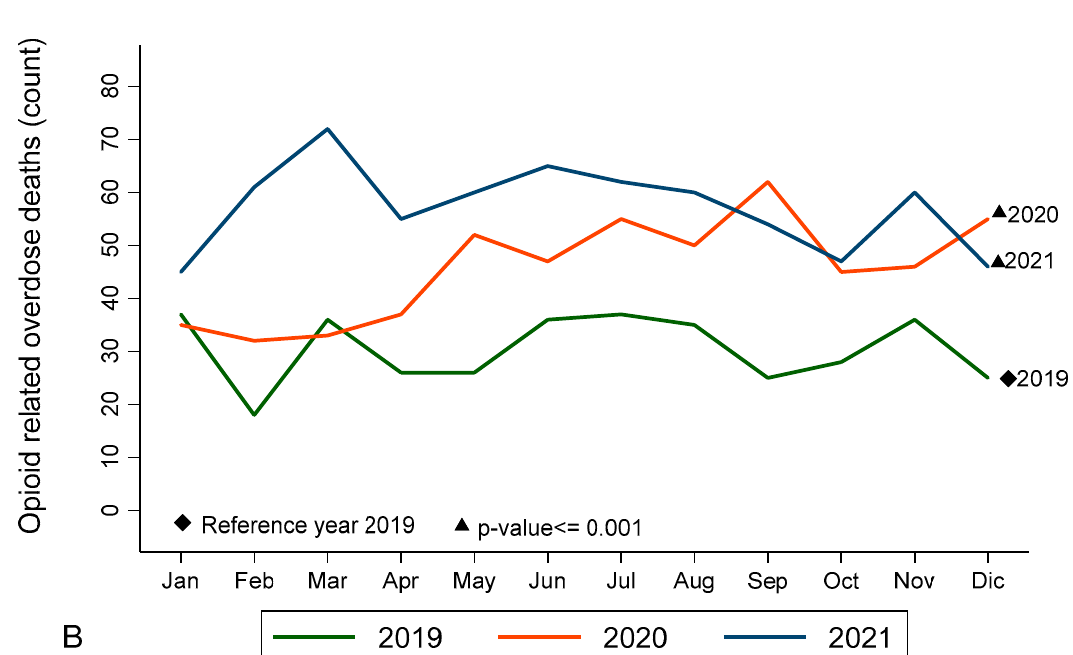
Figure 1. Time trends of opioid-related overdose deaths in the metropolitan Houston area from 1 January 2015 to 31 December 2021. Source: Harris County Institute of Forensic Sciences. Compared to 2015, the trends showed a significant increase in deaths after 2018 ( p -value < 0.001), which is shown in solid lines. (See subfigure A ). Compared to year 2019, the trends showed a significant increase in deaths for 2020 and 2021 ( p -value < 0.001). (See subfigure B